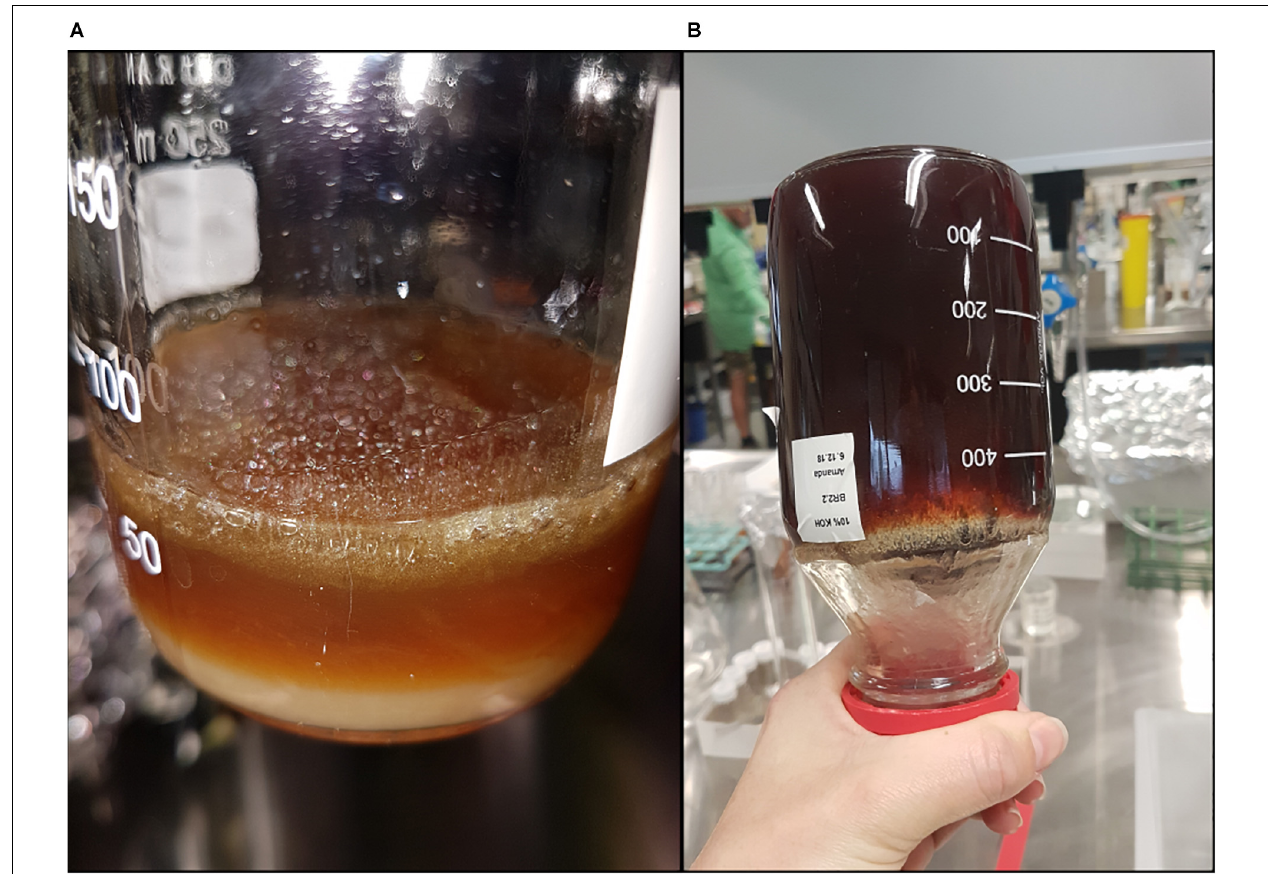
FIGURE 3 | Saponified viscera samples of barramundi ( Lates calcarifer ) (Experiment A) after treatment with 10% potassium hydroxide (KOH) at ambient room temperature ( ∼ 22 ◦ C) for 14 days, (A) sample with a single layer of gel floating atop a liquid layer, gel is approximately 0.5 cm thick, and (B) entire sample ( ∼ 500 mL) has saponified due to agitation and formed a solid soft